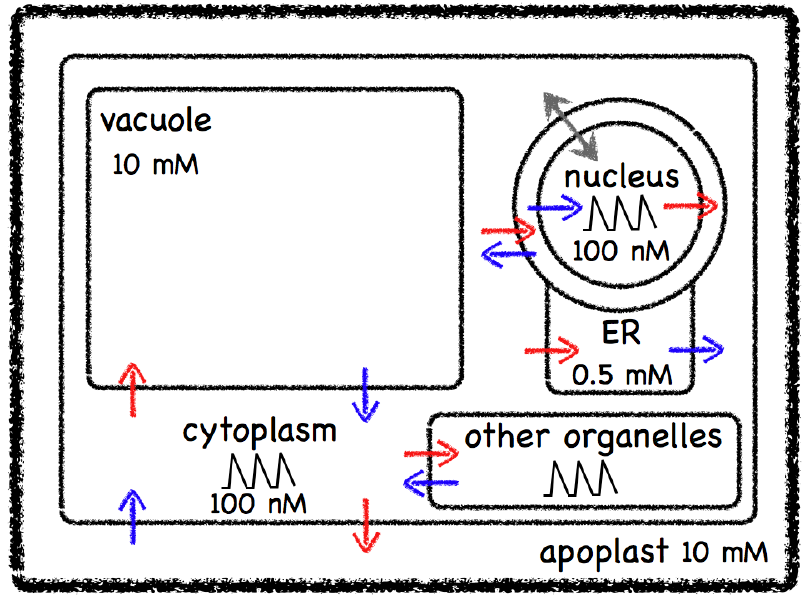
Figure 1. A schematic view of a plant cell showing some of the main calcium stores and cellular compartments with their approximate free calcium ion concentrations. Calcium channels are shown as blue arrows, pumps are shown as red arrows, whilst the grey double arrow depicts diffusion through the nuclear